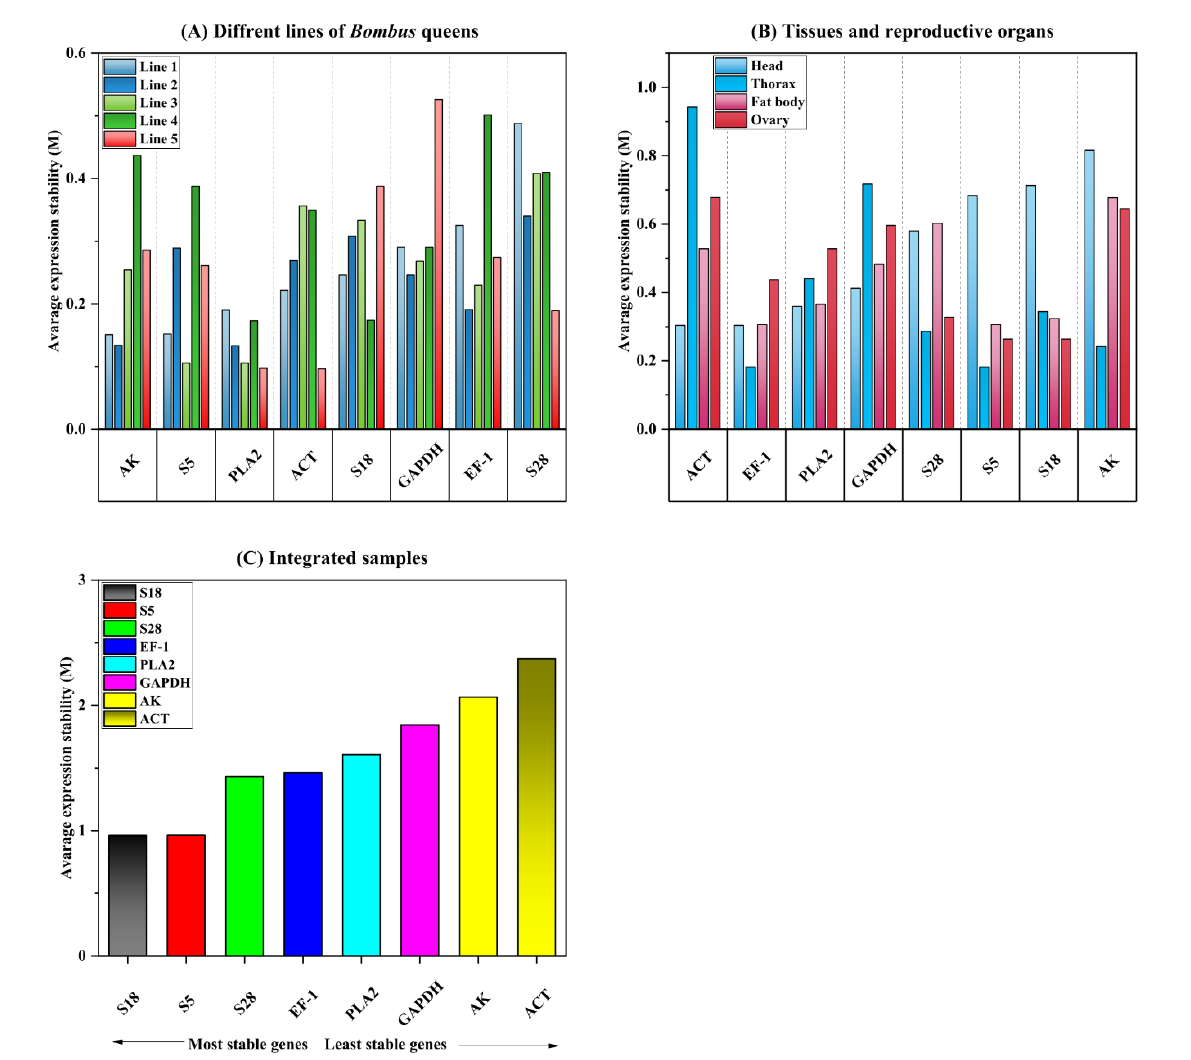
Figure 4. GeNorm calculated the expression stability values (M) of the eight-candidate bumble bee reference genes. Five different lines ( A ), four tissue and reproductive organ types ( B ), and an integration of all samples were used to prepare samples ( C ).